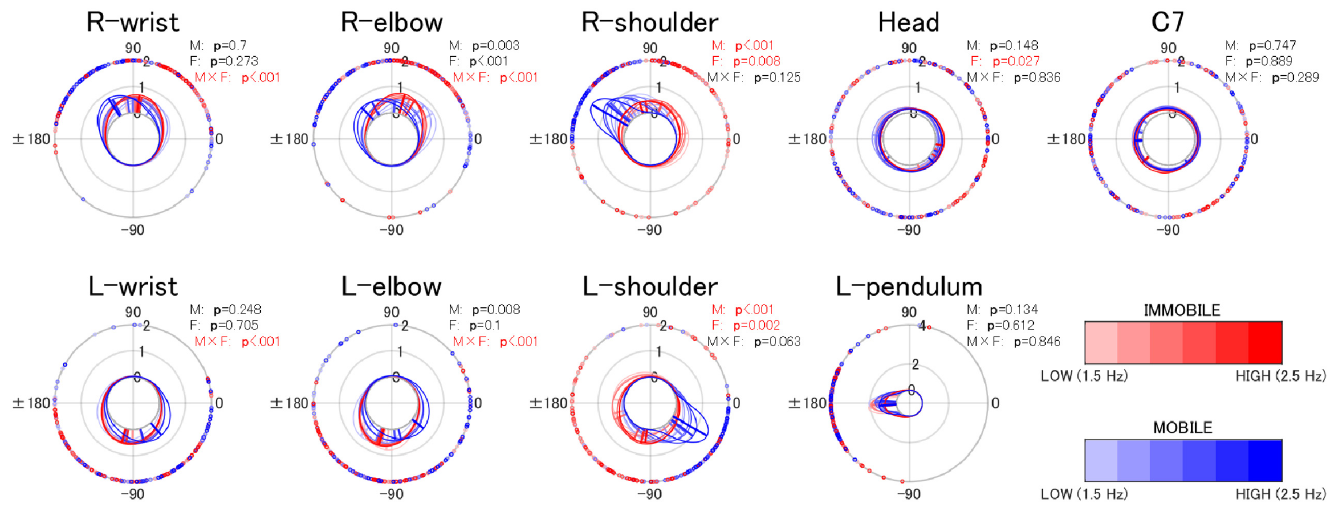
Fig 7. Phase difference between the pendulum and body parts (anti-phase) ( N =18). Fig 7 represent the same information as Fig 6, except that the data are for anti- phase.